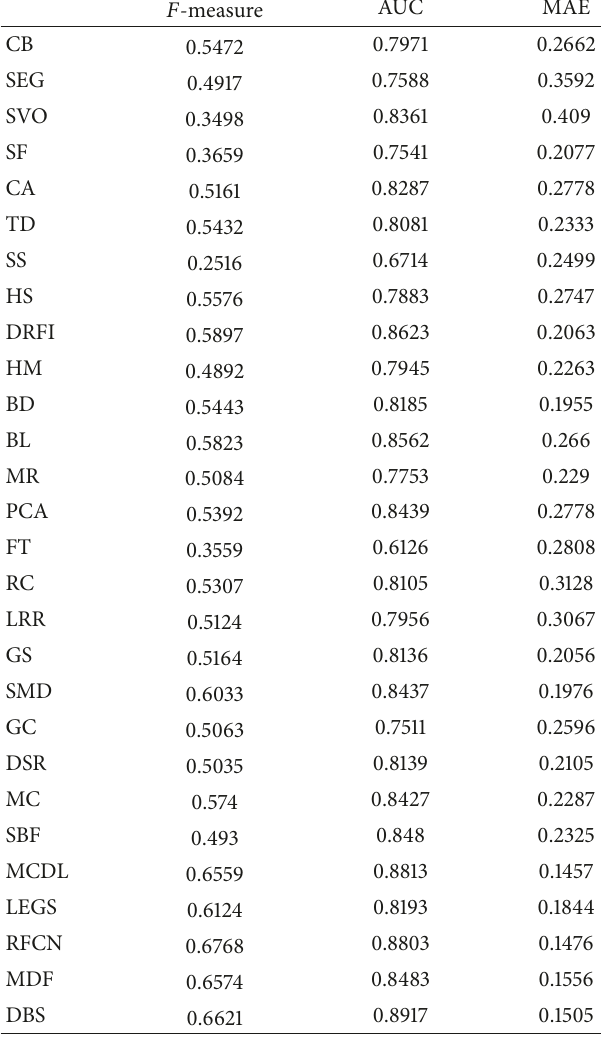
Table 1: 𝐹 -measure, AUC, and MAE of DBS and 27 state-of-the-art